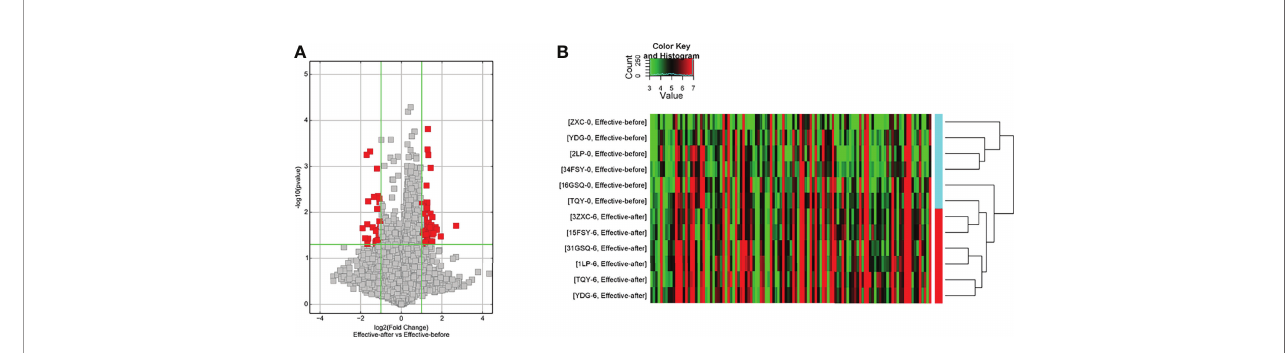
FIGURE 3 | Differentially expressed lncRNA in disease group after treatment and before treatment [ (A) Volcano map; (B) Clustering heat